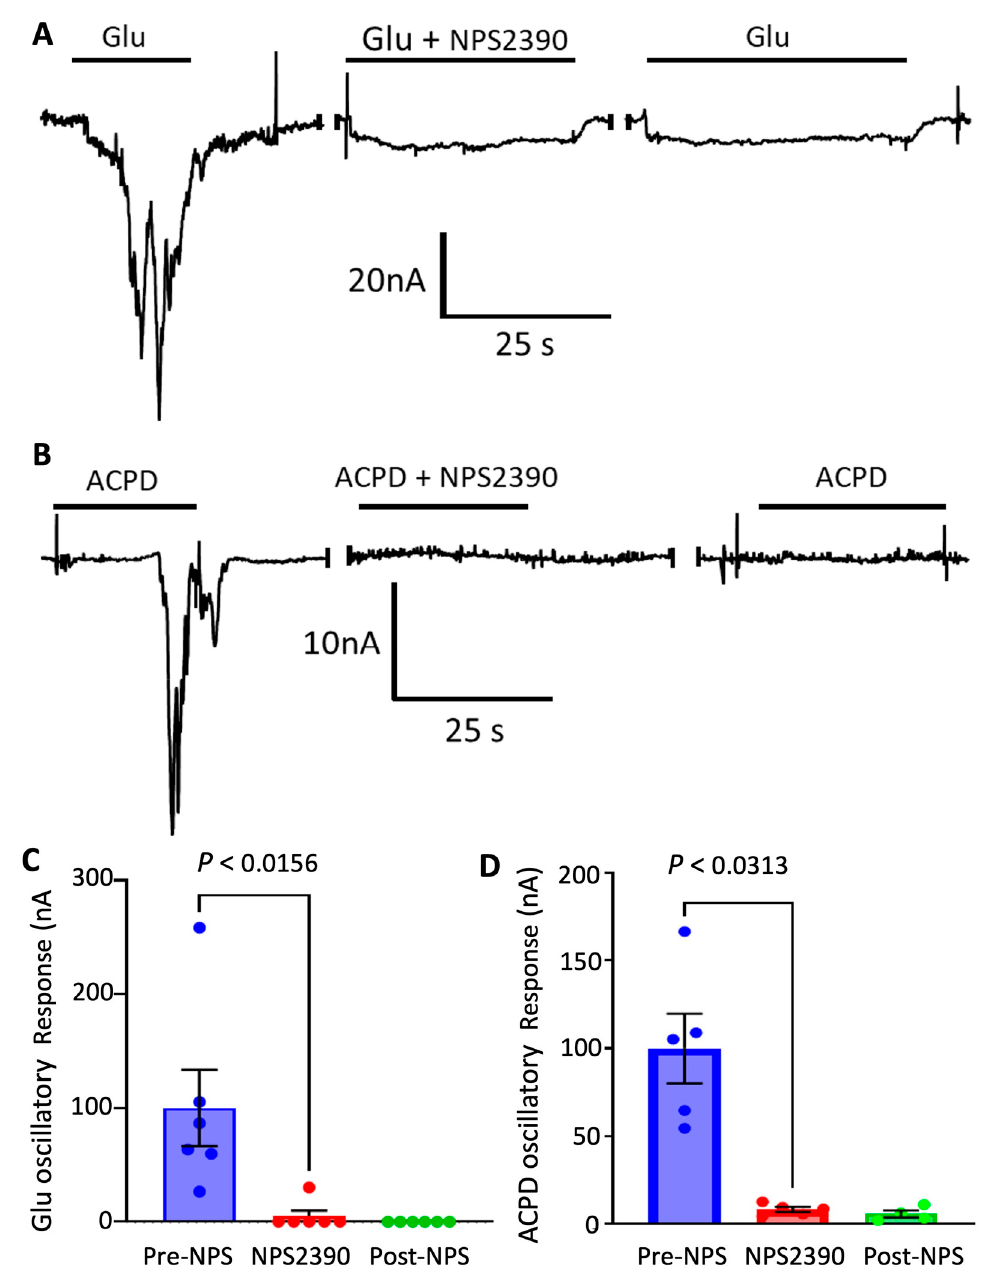
Figure 3. Antagonism of Group 1 receptors inhibits oscillatory glutamate responses. ( A ) Glutamate currents from the same microtransplanted oocyte; each application was separated by a 4 min washing period of Ringer’s solution. A complete loss of oscillations is shown during the application of 10 µ M NPS 2390, a mGluR group 1 antagonist ( n = 6 oocytes from 1 frog). ( B ) ACPD currents of a microtransplanted oocyte with each application type separated by a wash period of 4 min of Ringer’s solution. ( C , D ) 10 µ M of NPS 2390 co-applied with glutamate or ACPD resulted in a complete loss of oscillations ( n = 6 and 5 oocytes from 2 frogs, for C and D, respectively). 3.3. Cortical mGluR 5 Type Receptors Are Mostly Responsible for Oscillatory Responses To determine how much mGluR1 and mGluR5 each contributed to metabotropic os- cillations, selective antagonists were used to test their effects on responses elicited by ACPD and glutamate. LY 456236, an mGluR1 selective antagonist, was tested at a 1 µM concentration on responses elicited by glutamate ( n = 13 oocytes) or ACPD ( n = 6 oocytes). LY 456236 did not inhibit the oscillatory responses by either agonist, suggesting that